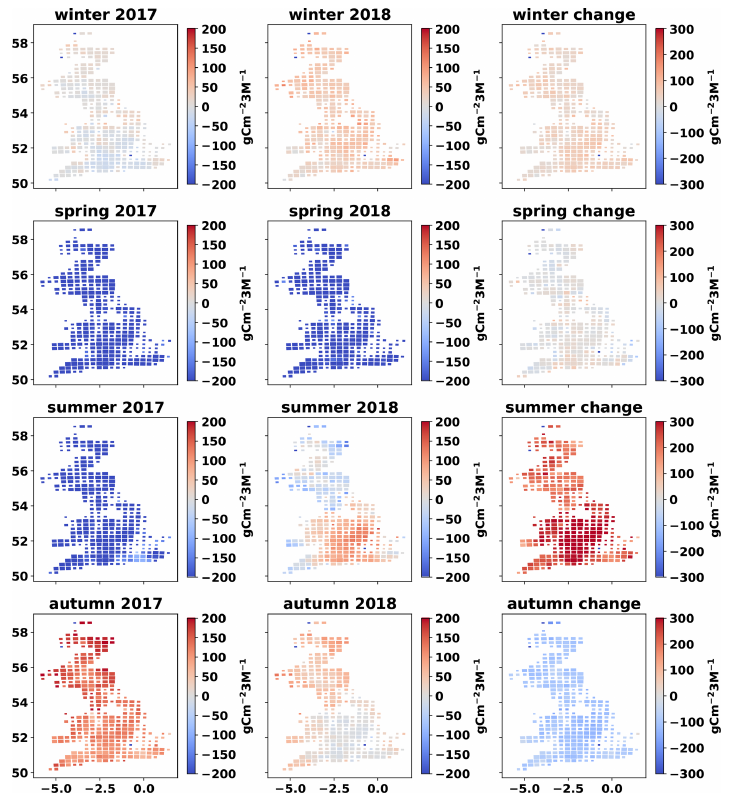
Figure A8. Cartograms of cumulative NEE per season for 2017 (December 2016–November 2017) and 2018 (December 2017– November 2018), and change in seasonal NEE from 2017 to 2018. The mean MDF-predicted seasonal NEE of all fields in each cell is presented. The size of cells is adjusted according to the number of simulated fields within